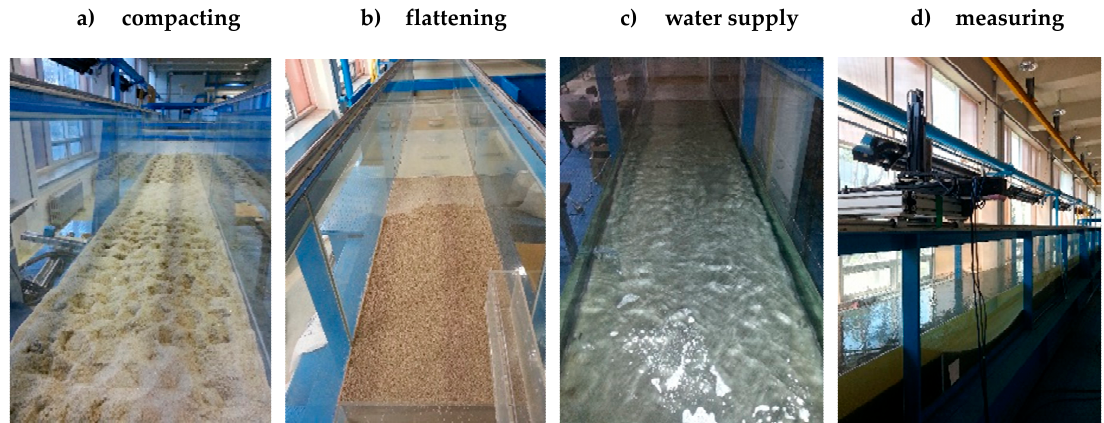
Figure 4. Arrangement of 3-D velocity and bed elevation measurement (left: sensor arrangement; right: schematic diagram).